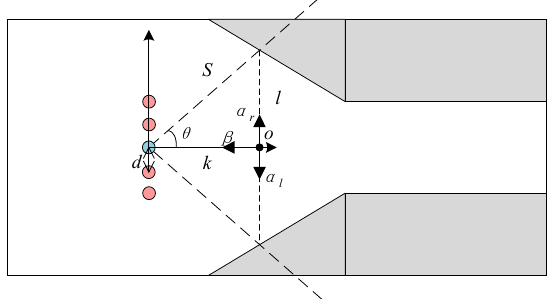
Figure 6. The impact of narrowing road boundaries on the UGVs fleet.